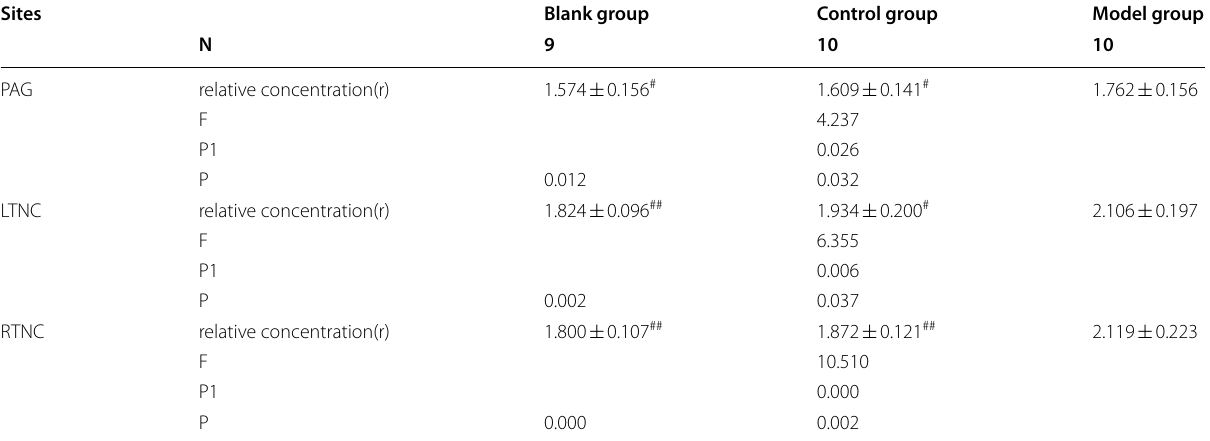
Notice: # Represents comparison with the model group, p < 0.05; ## Represents comparison with the model group, p < 0.01; P1 Indicates the p value of one-way analysis or Kruskal-Wallis H test